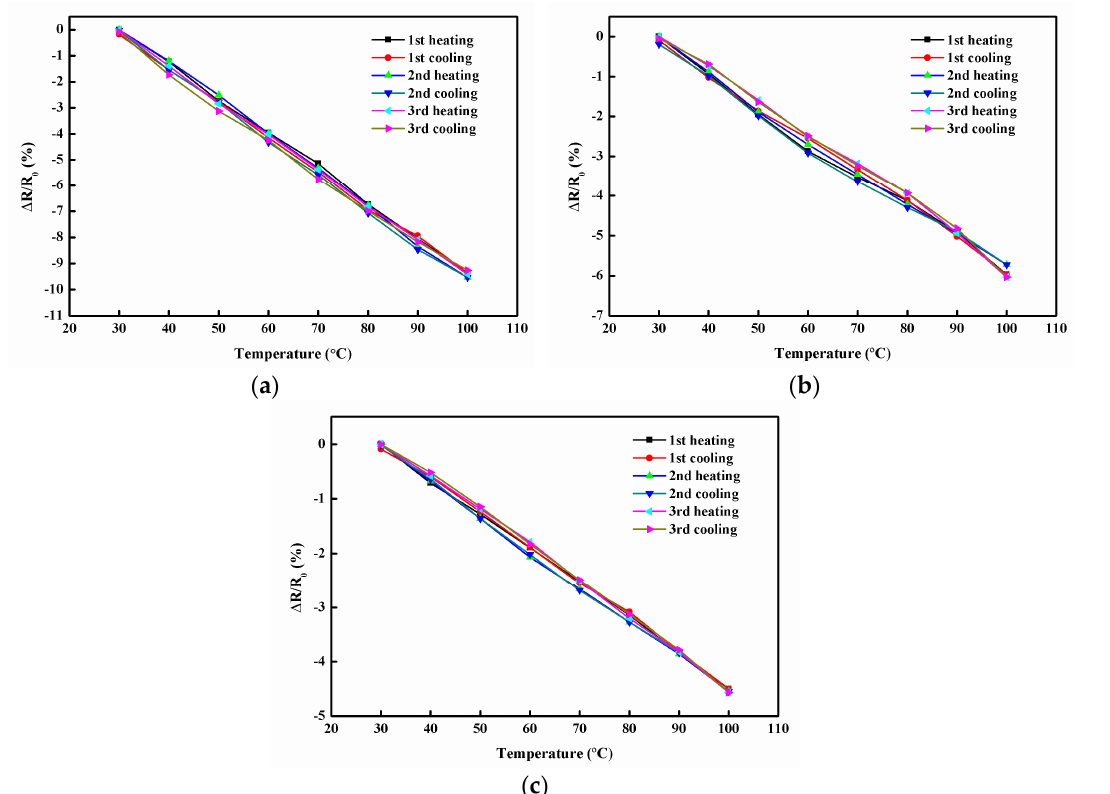
Figure 12. Normalized relative resistance change of the hybrid films subjected to cyclic heating and cooling